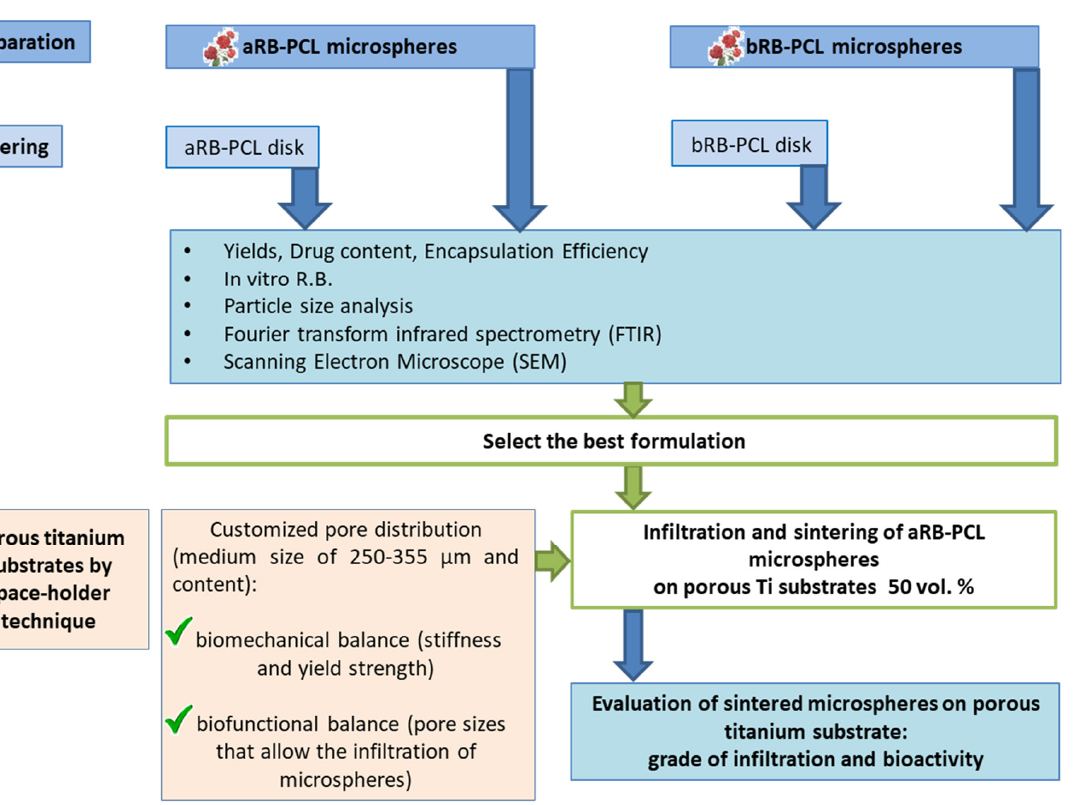
Figure 1. Workflow of the experimental work is shown in